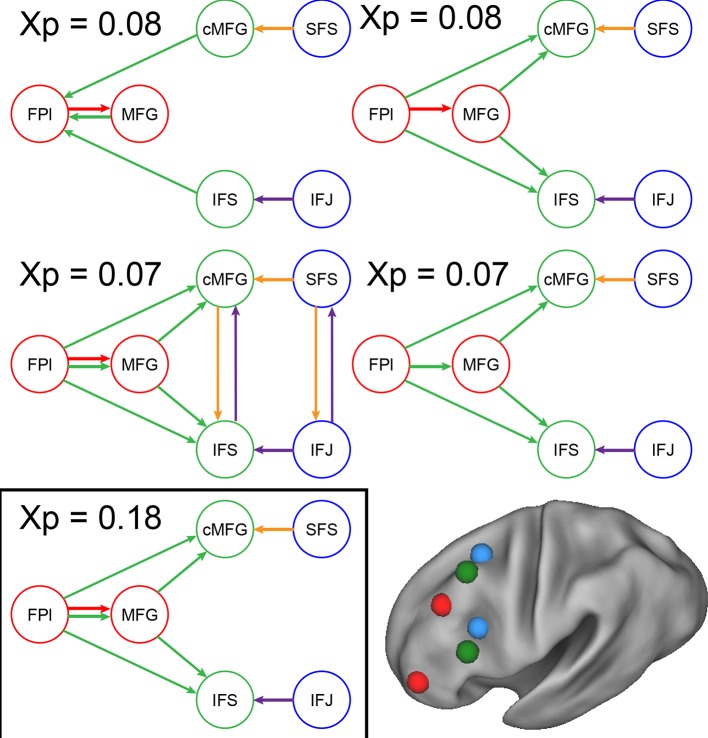
Model comparison.Modulatory parameter structure for the winning (bottom left) and closest competitor models. The depicted models are the only models with exceedance probabilities (Xp) greater than 0.05, among the 99 models examined. The closest competitors all closely resembled the winning model. Red arrows – modulation by Temporal Control; green arrows – modulation by Contextual Control; orange arrows – modulation by Spatial Stimulus Domain; purple arrows – modulation by Verbal Stimulus Domain.